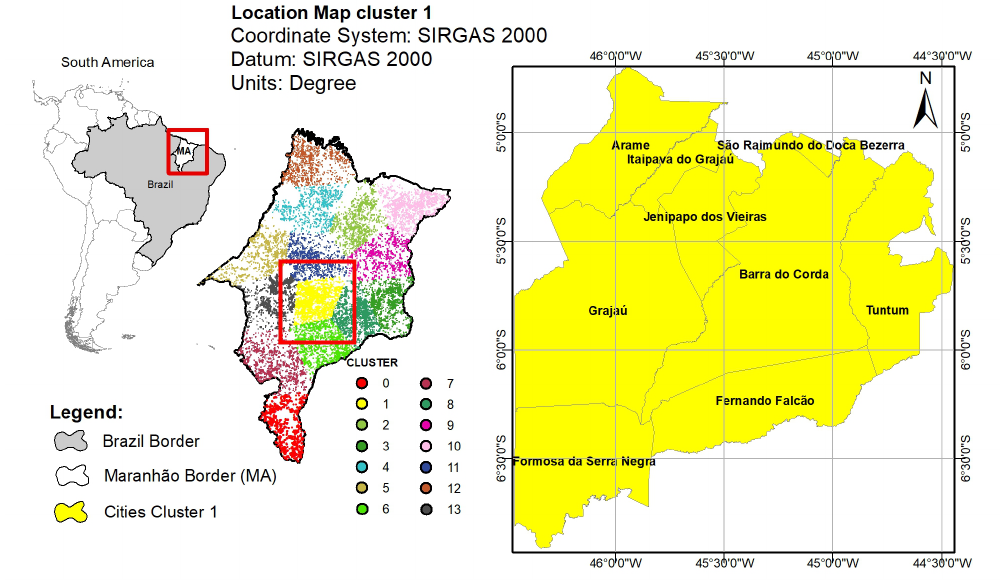
Figure 5. Cluster Distribution for the state of